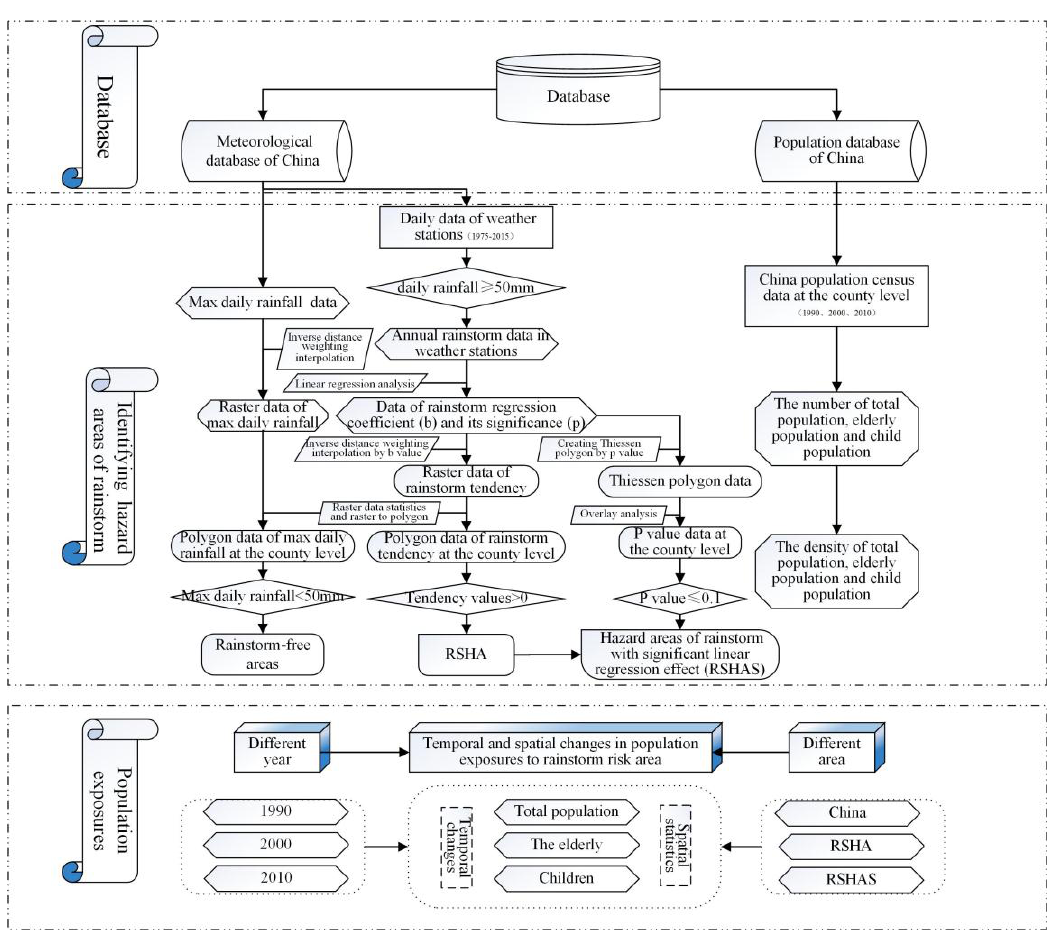
Figure 1. The technical roadmap. RSHA: rainstorm risk hazard area.